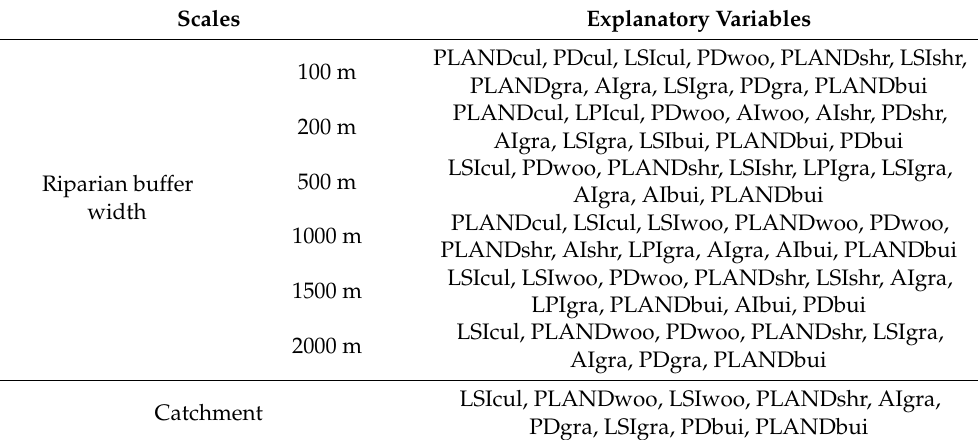
Table 2. Significant explanatory variables screened out by stepwise regression